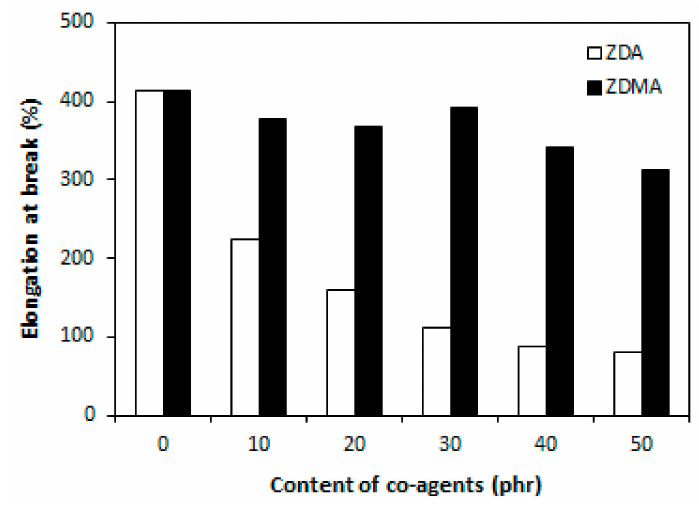
Figure 5. Influence of co-agents content on elongation at break of composites.